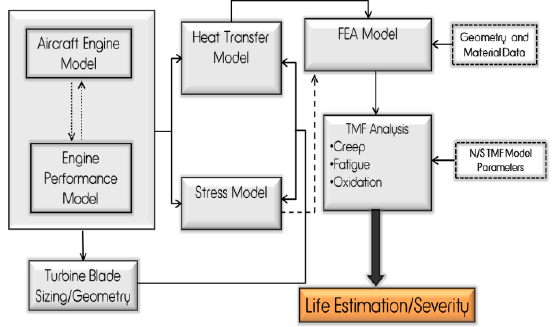
Figure 1: Lifing assessment